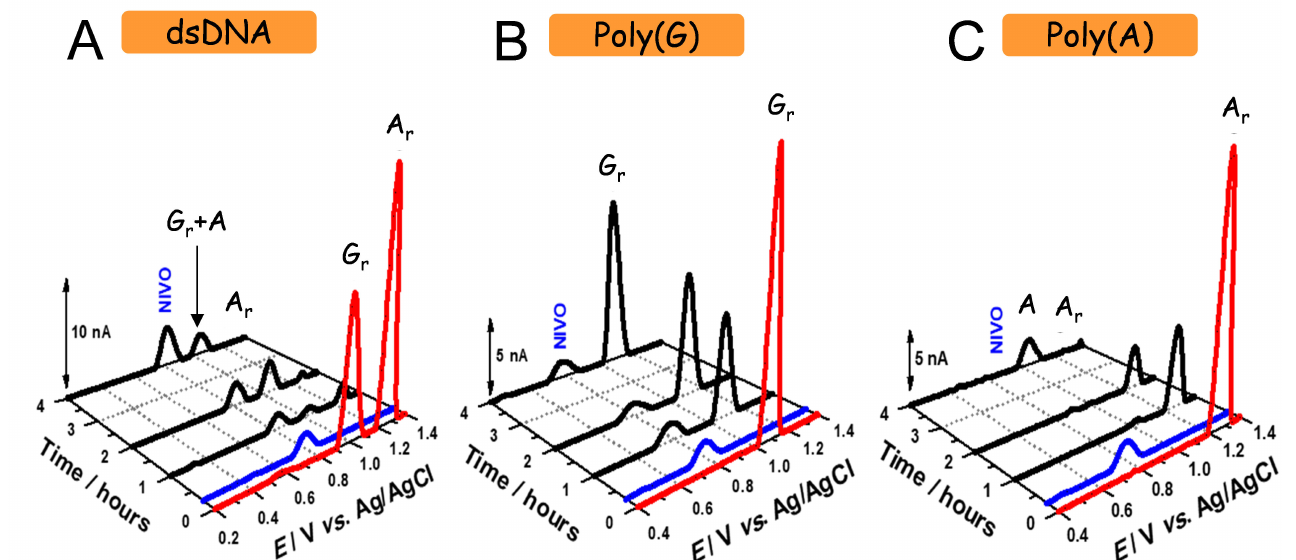
Figure 8. Baseline-corrected DPV at pH 4.5, for (blue line) control nivolumab (NIVO), (red line) control ( A ) dsDNA, ( B ) poly(G), and ( C ) poly(A) electrochemical biosensors and (black line) after incubation with NIVO for different time periods. Adapted from [98] with